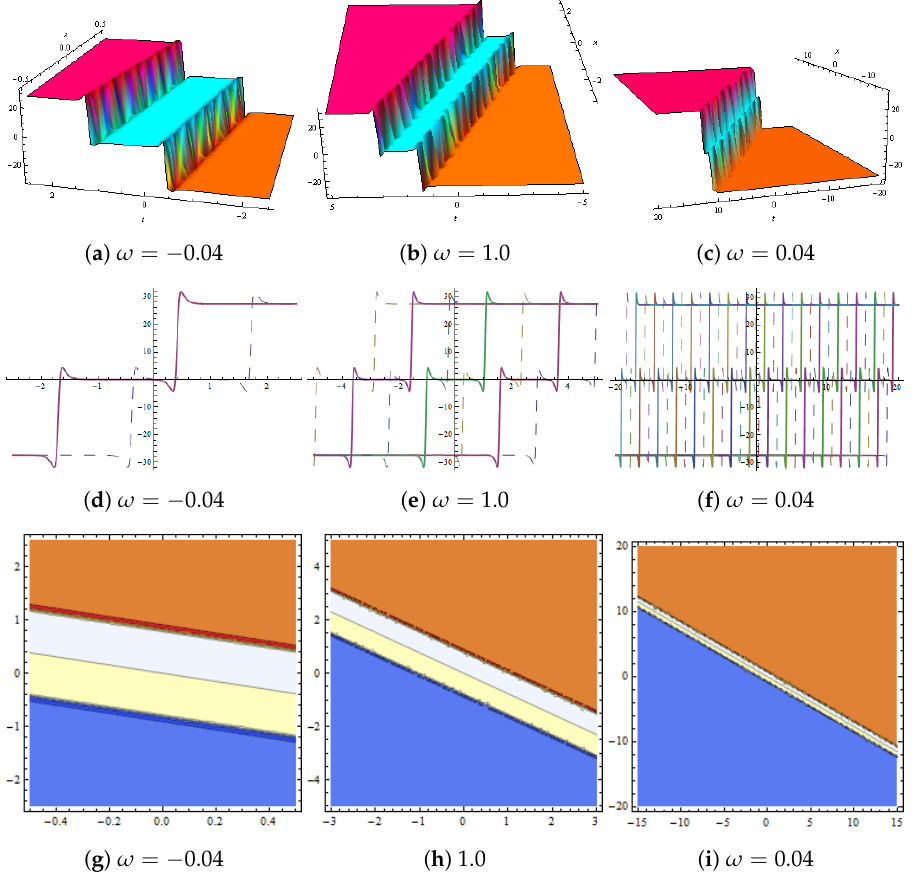
Figure 11. ( a – c ) show 3D graphs. Dynamical representation of solution v ( x , t ) in Equation (33) with β 2 = 0.2, β 3 = 3.5, ζ = 0, l 2 = 0.03, Q = 5, r 1 = 2.5, w 2 = 5, w 3 = 0.3, w 4 = 0.9, φ = 1.7. ( d – f ) show 2D plots and ( g – i ) represent contour graphs for various values of ω